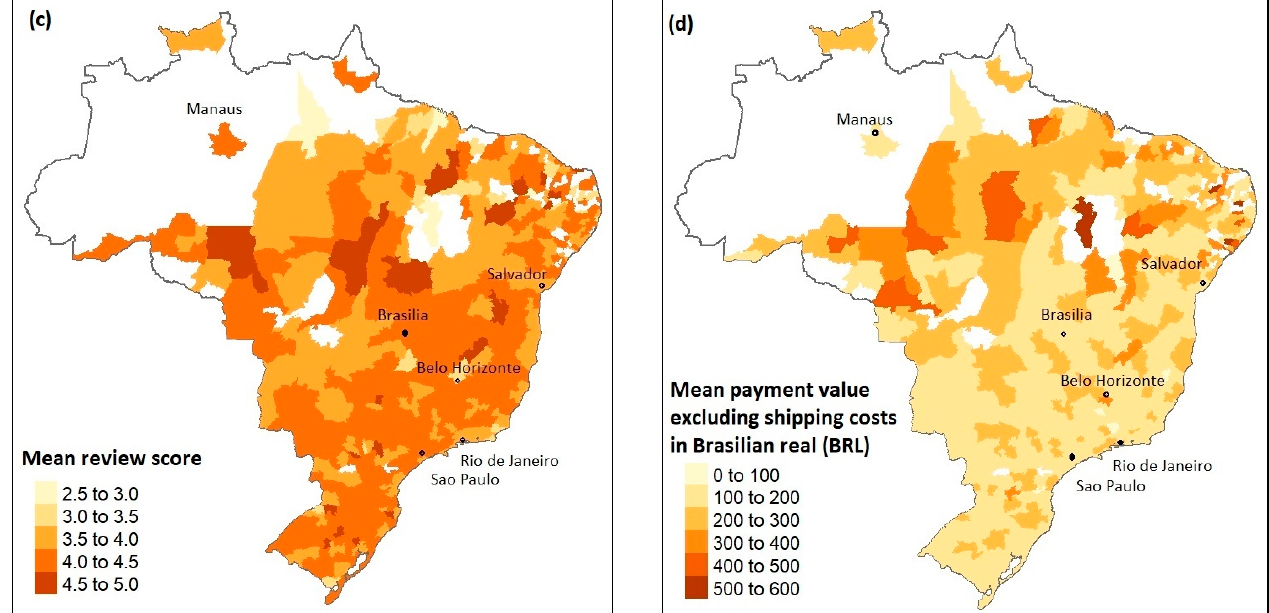
Figure 8. Spatial statistics of customers by micro-regions: ( a ) number of customers per 10,000 inhabitants, ( b ) percentage of customers who placed a second order, ( c ) mean review score, ( d ) mean payment value. Note: regions with less than 5 customers were removed as the summary statistics would be biased.